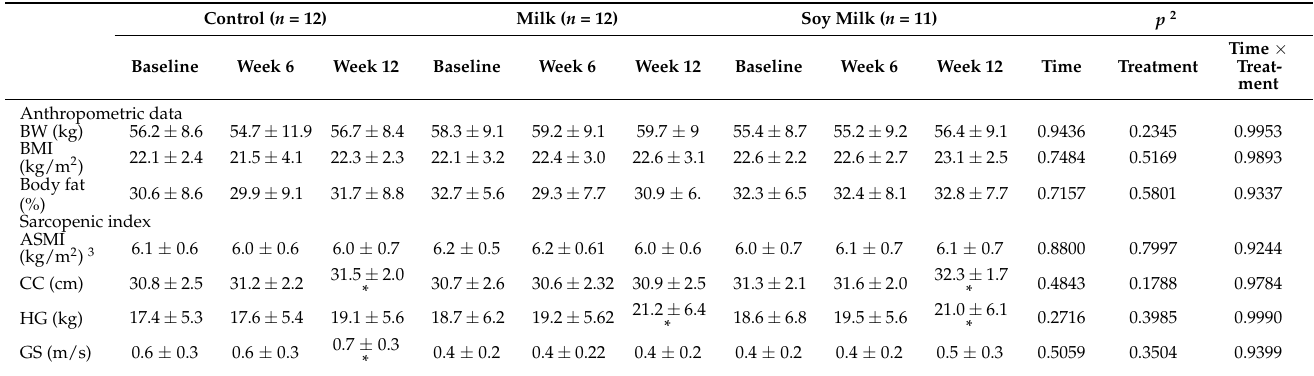
Table 3. Effects of milk or soy milk combined with resistance exercise on anthropometric data and sarcopenic index in very old nursing home residents with sarcopenia 1 .